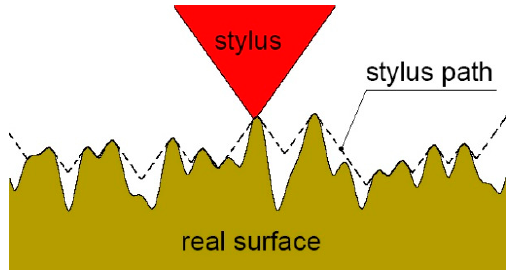
Figure 2. Graphical interpretation of mechanical filtration by the tip of the stylus, adapted from [24]. The path of the spherical tip of the stylus was modeled, according to [25]. In this case,